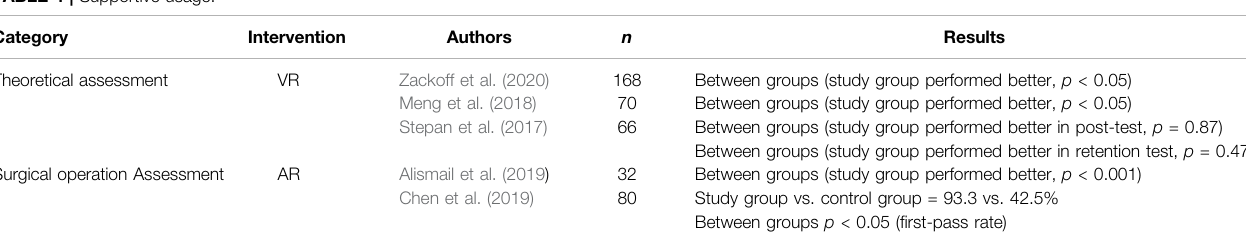
TABLE 4 | Supportive usage. Category